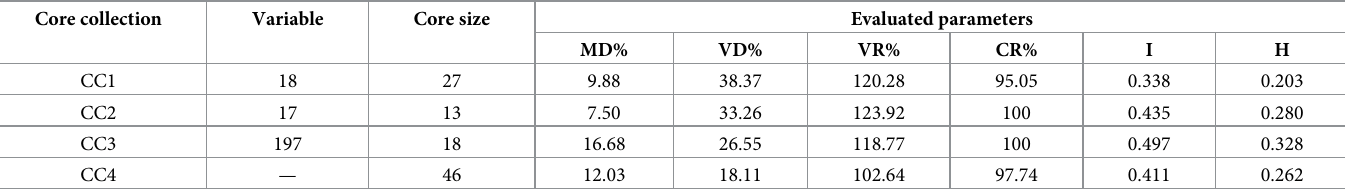
Table 4. Evaluation indices for the developed core